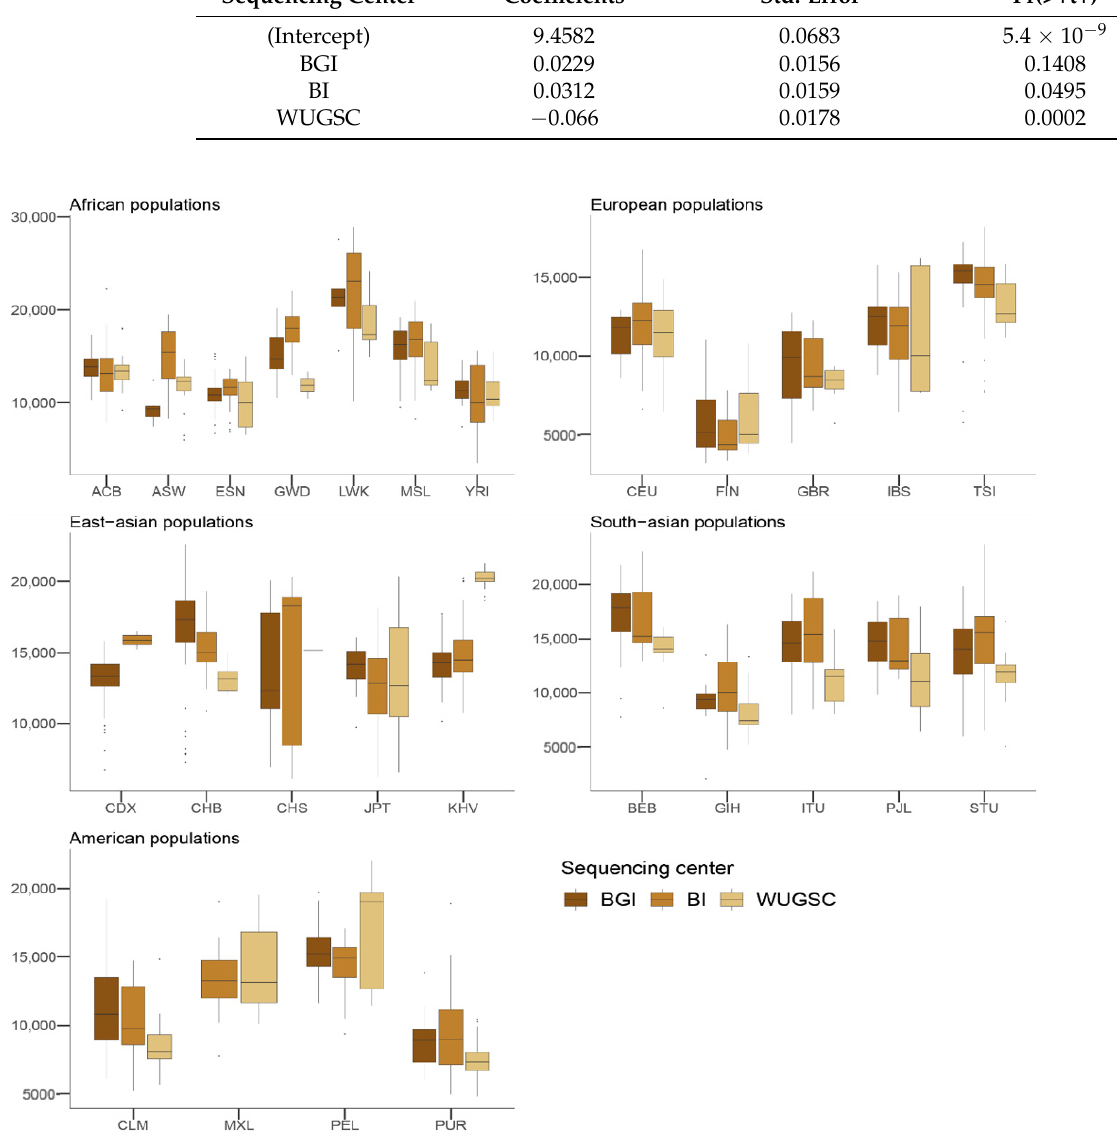
Figure 4. Number of derived singletons by sequencing centers across continental groups and popu- lations. Each panel corresponds to a continental group. In the x -axis the name of the population is displayed; in the y -axis the number of derived singletons per individual is displayed. Acronyms are showed in Supplementary Materials Table S1. Table 3. Coefficient, standard error, and p value of the coefficient from the hierarchical mixed model using the number of derived singletons as the dependent variable. For this analysis, we only con- sidered sequencing centers that sequenced samples across all populations. Sequencing Center